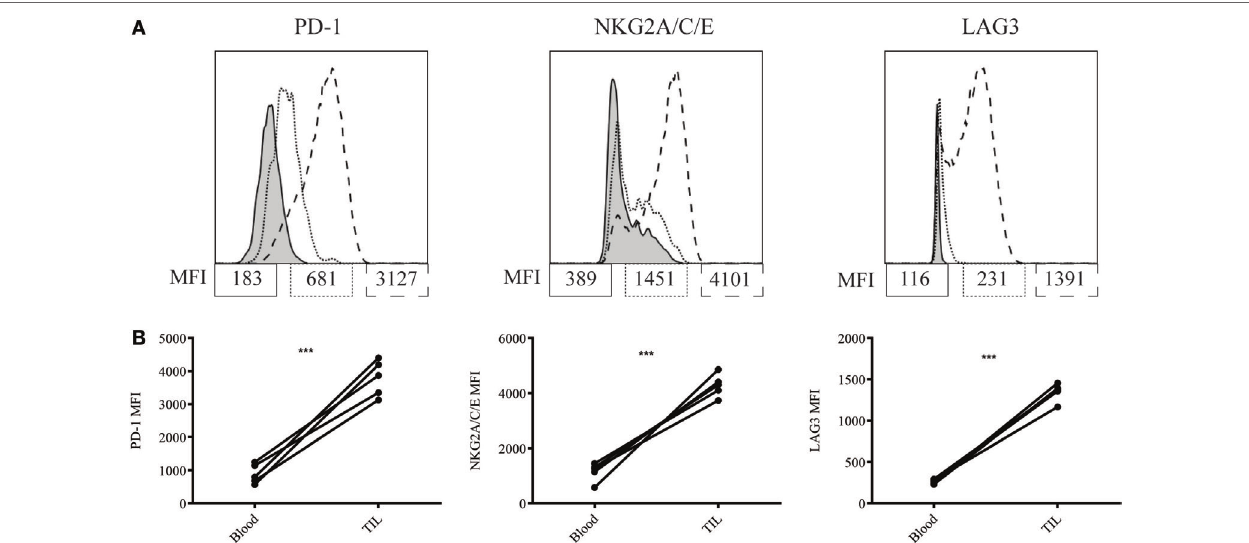
FigUre 5 | MCMVgp100KGP stimulated PMEL cell upregulate inhibitory receptors within the tumor microenvironment. Mice bearing B16F10 tumors were treated with PMEL transfer i.v. and 10 5 PFU MCMVgp100KGP vaccination i.p. Six days later, peripheral blood and tumor tissue were harvested for flow cytometry. (a) Representative plots of inhibitory receptor expression on PMEL cells from peripheral blood (dotted lines) and tumor tissue (dashed lines). Shaded curves represent FMO controls. (B) Inhibitory receptor MFI on PMEL cells from peripheral blood vs. tumor tissue. *** p < 0.001. Paired t -test. n = 5 mice/group. Data are representative of three independent